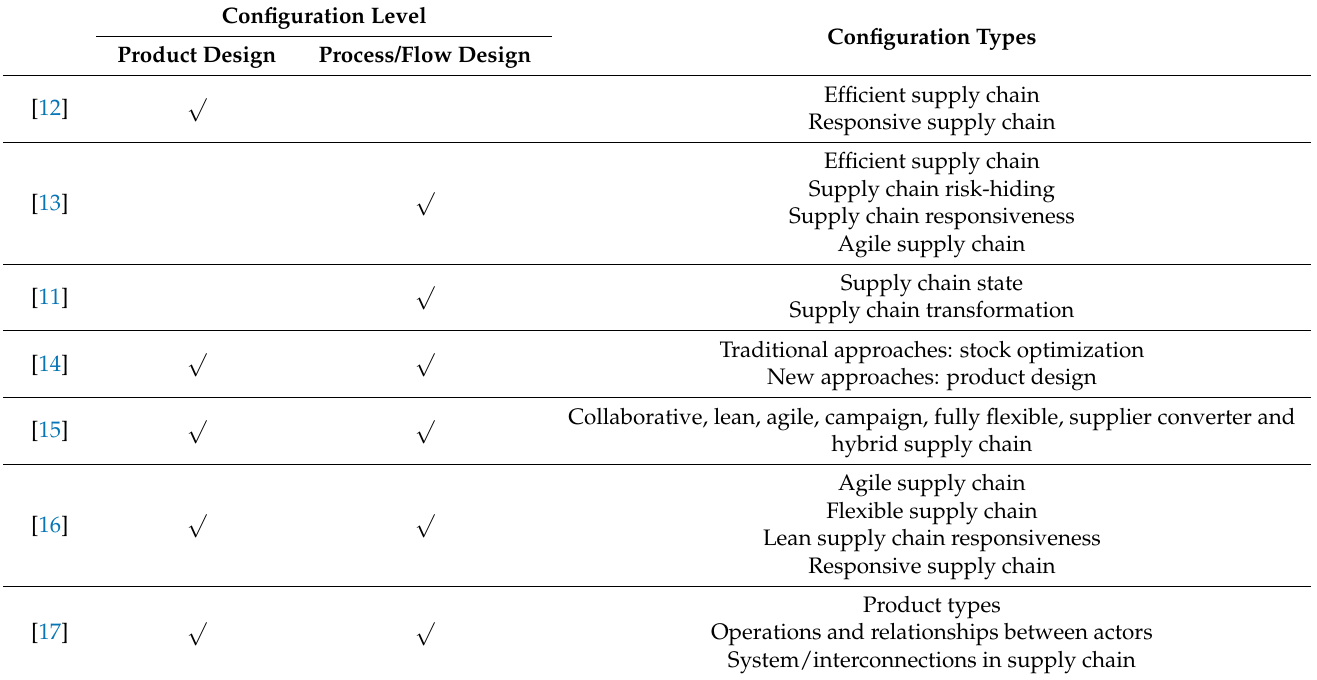
Table 1. Supply chain configuration